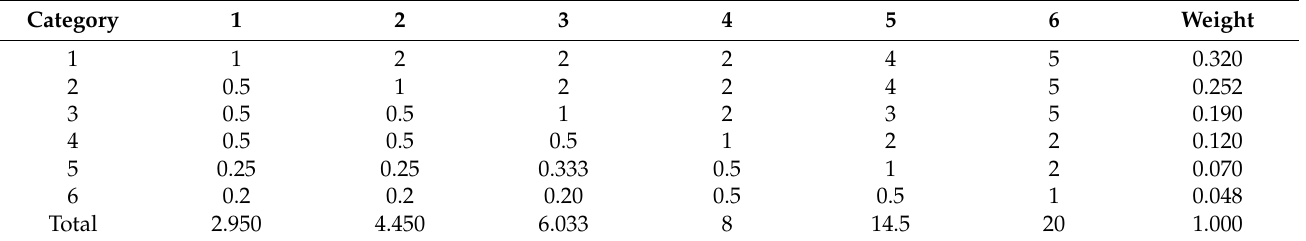
Table 5. Matrixconstructionandweightingcalculationforcategoriesassociatedwithfailureriskassessment.